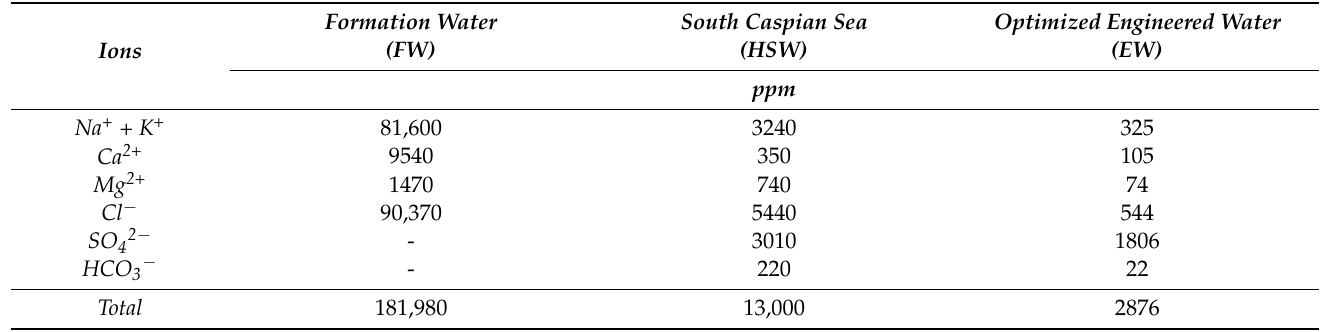
Table 2. Ionic compositions of formation water, high salinity water, and engineered